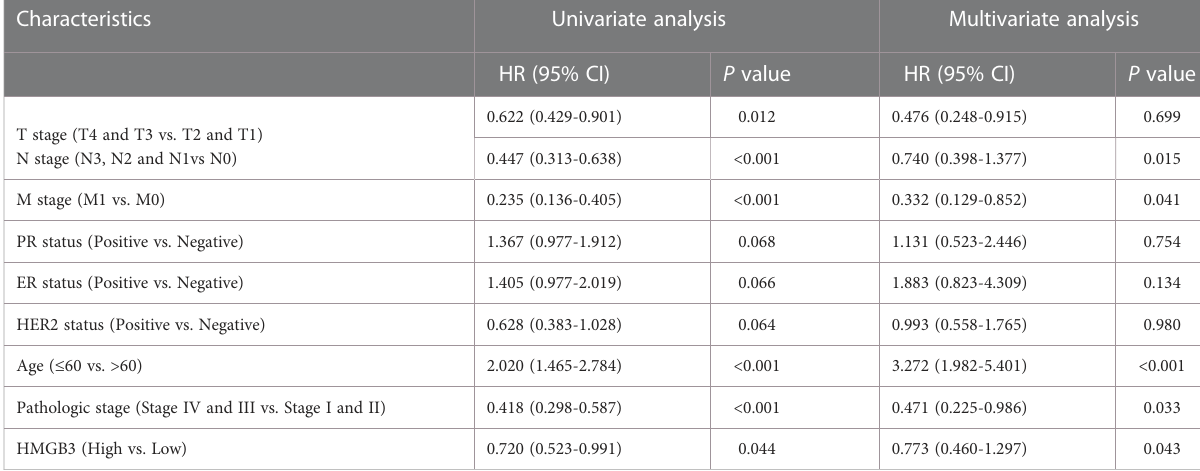
TABLE 2 Univariate and multivariate Cox analyses of overall survival in breast cancer.